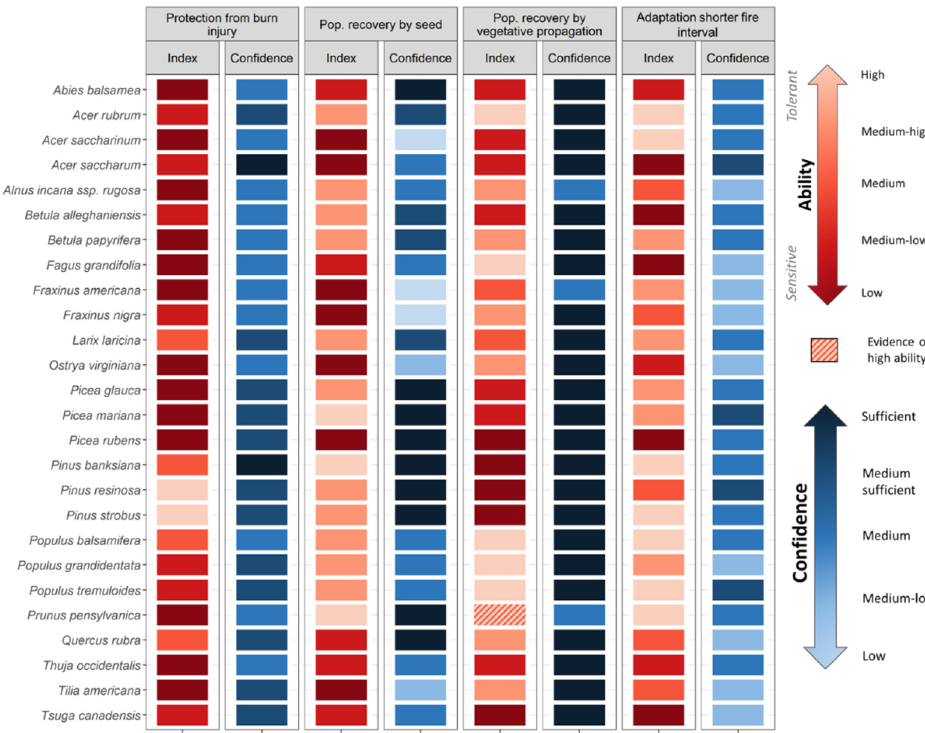
Figure 4. Tree species ability to persist through more frequent and intense fires, as characterised by four main strategies: Protection from burn injury, Population recovery by seed, Population recovery by vegetative propagation, Adaptation to shorter fire intervals. Each index ranks the relative ability (from low/sensitive to high/tolerant, reds) of tree species for a specific strategy (see Scheme 3 for which mechanisms/traits were considered). Species for which information was not available were attributed an intermediate value, depending if there was evidence of tolerance or not (diagonal hatched stripes: dark red hatched—evidence of low ability; light red hatched—evidence of high ability). Confidence associated with available data is also presented, as ranked from low to sufficient (blues). For more details on definitions and ranking, see Table S3.